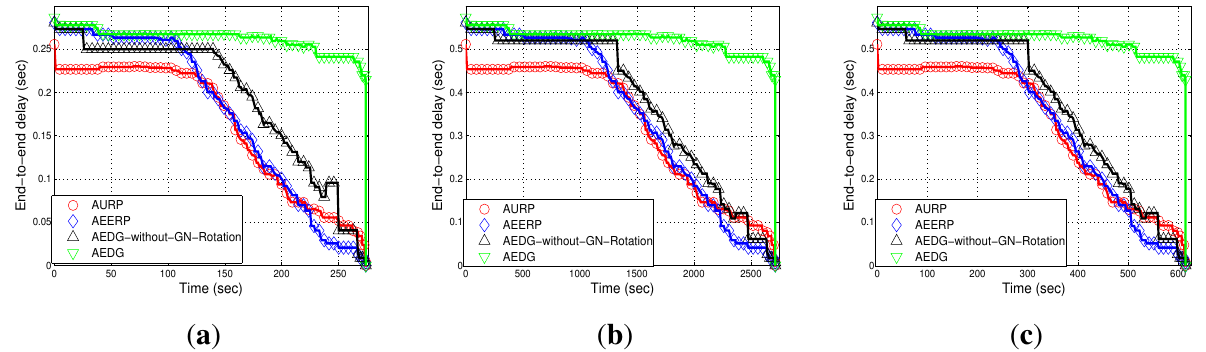
Figure 12. End-to-end delay. ( a ) 10 nodes deployed in 100 m × 100 m; ( b ) 100 nodes deployed in 100 m × 100 m; ( c ) 100 nodes deployed in 10 km × 10 km.